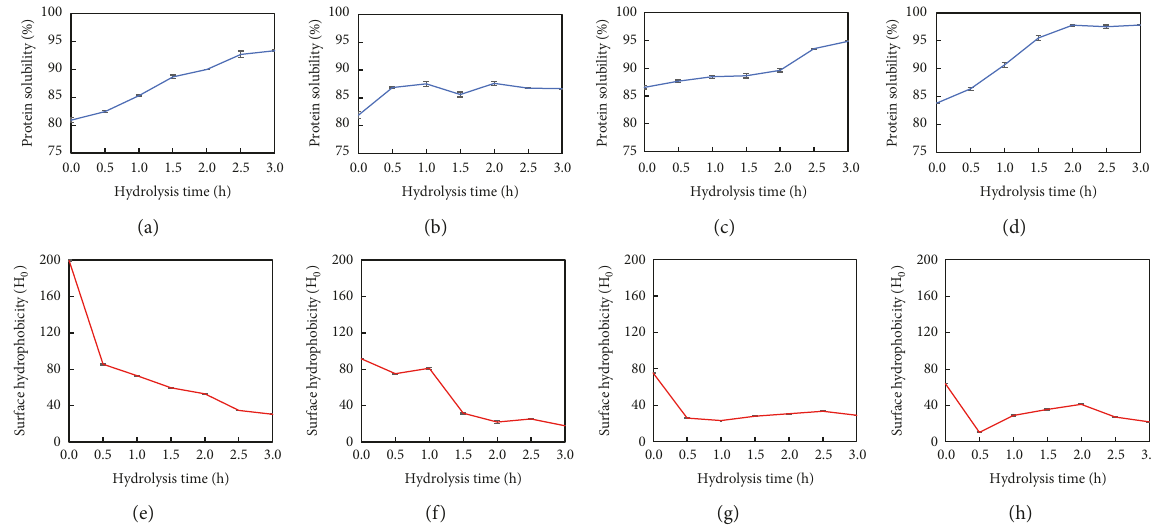
Figure 6: Protein solubility behavior of (a) nonextruded, (b) Ex60-HSPP, (c) Ex80-HSPP, and (d) Ex100-HSPP. Surface hydrophobicity behavior of (e) nonextruded, (f) Ex60-HSPP, (g) Ex80-HSPP, and (h) Ex100-HSPP.